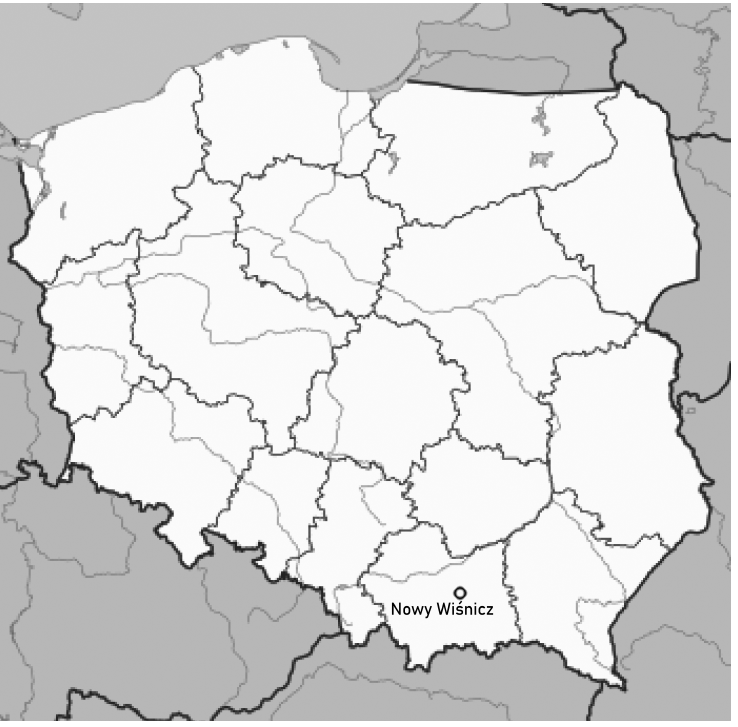
Figure 1. Location of Nowy